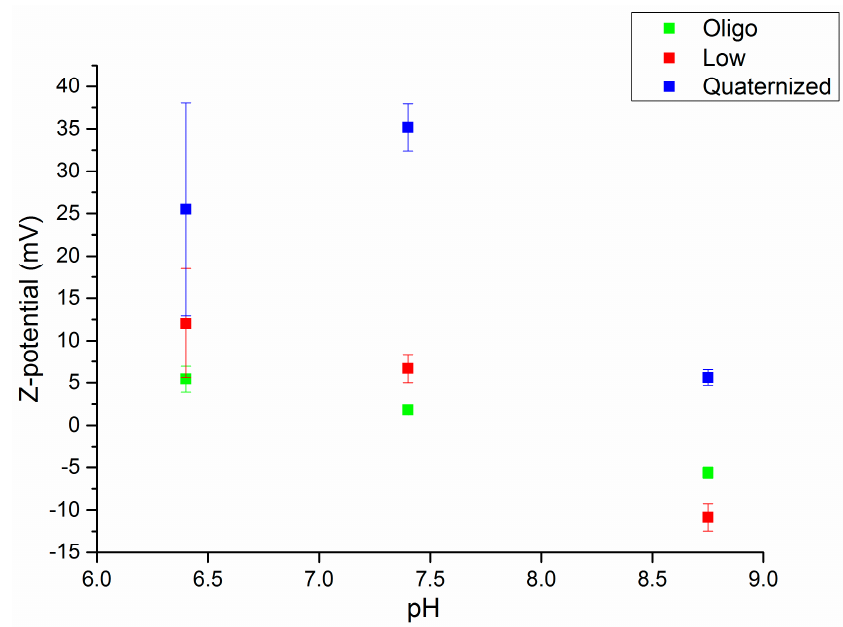
Figure 9. ζ -potential with the pH for each of the synthesized nanogels.